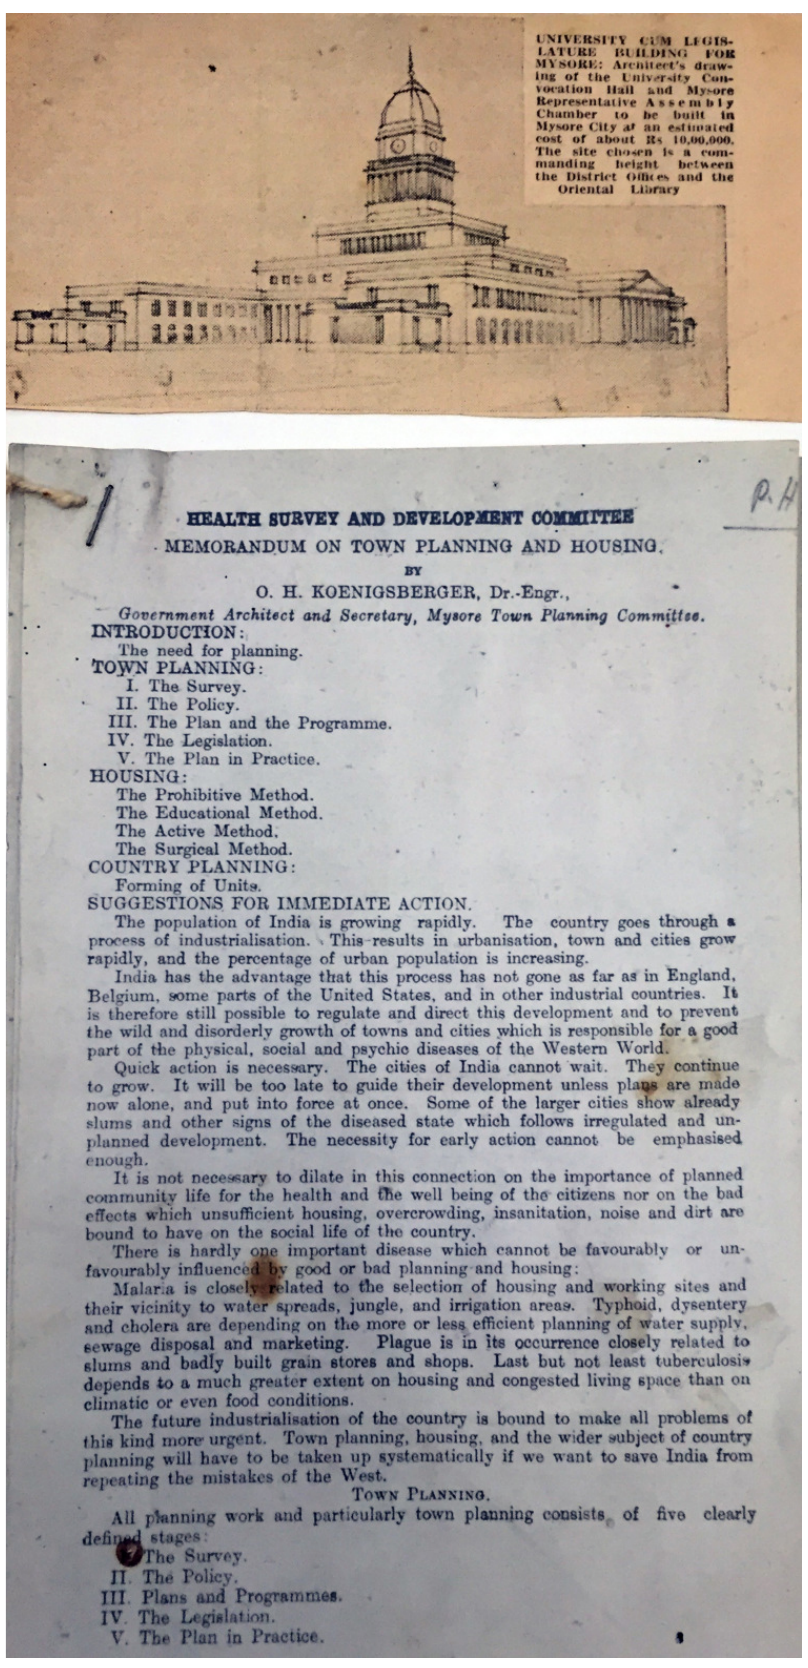
Figure 1. Otto Koenigsberger’s Health Survey and Development Committee Memorandum on Town Planning and Housing, with drawing of a university building for Mysore. Source: Koenigsberger